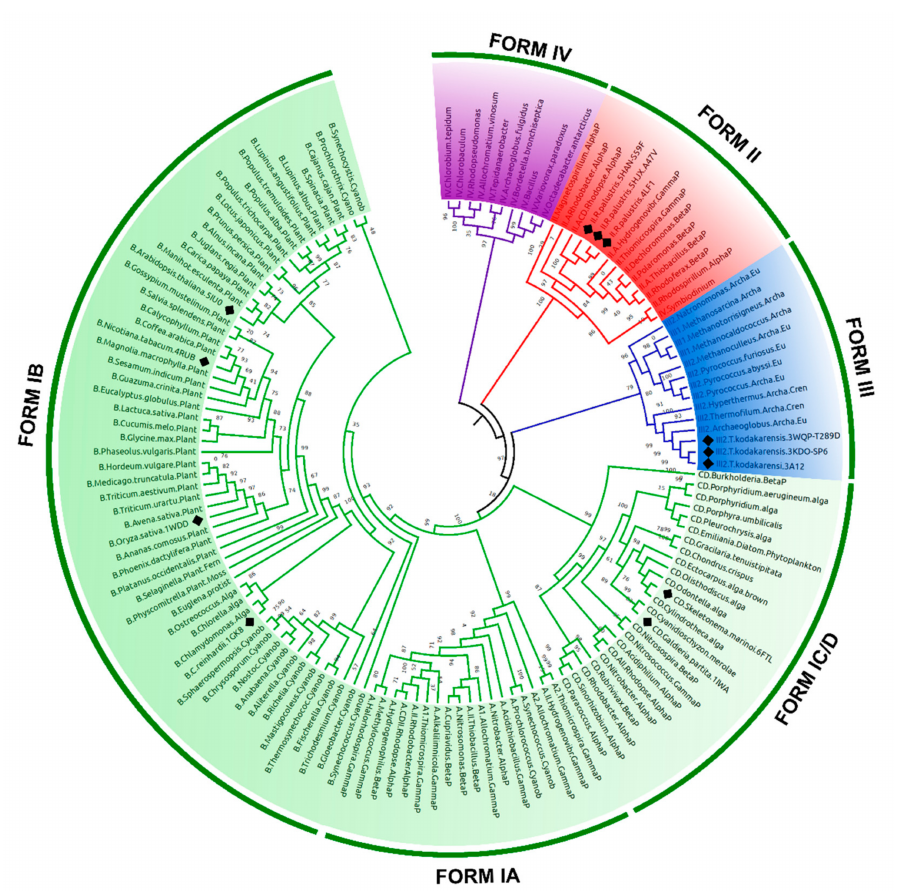
Figure 2. Maximum likelihood phylogenetic analysis of the RuBisCO RbcL protein family. Four forms of RuBisCO were classified along an evolutionary trajectory from the most recent common ancestor. Ancestral sequences were tagged according to their position in the RuBisCO subfamilies. Phylogenetic positions of the selected Wt and mutant proteins were marked with a black